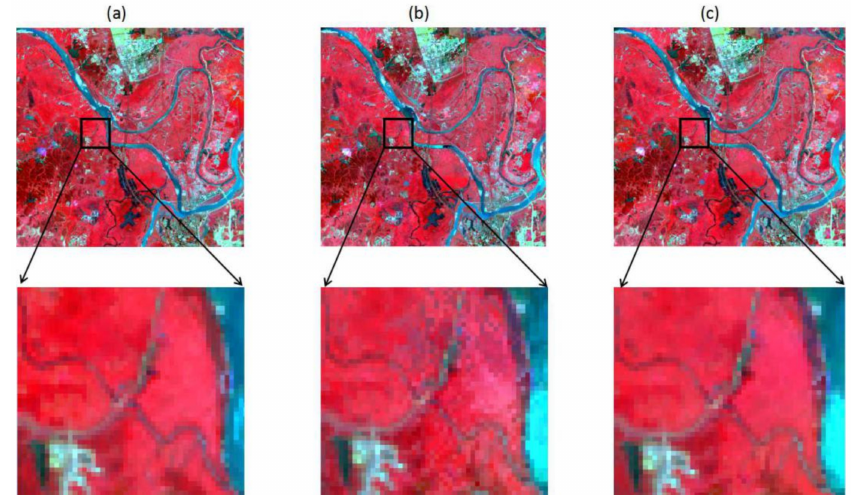
Figure 5. The comparison of actual images and predicted images using di ff erent spatiotemporal data fusion algorithms. ( a ) is the actual image; ( b ) is the predicted image by ESTARFM; ( c ) is the predicted images by the modified